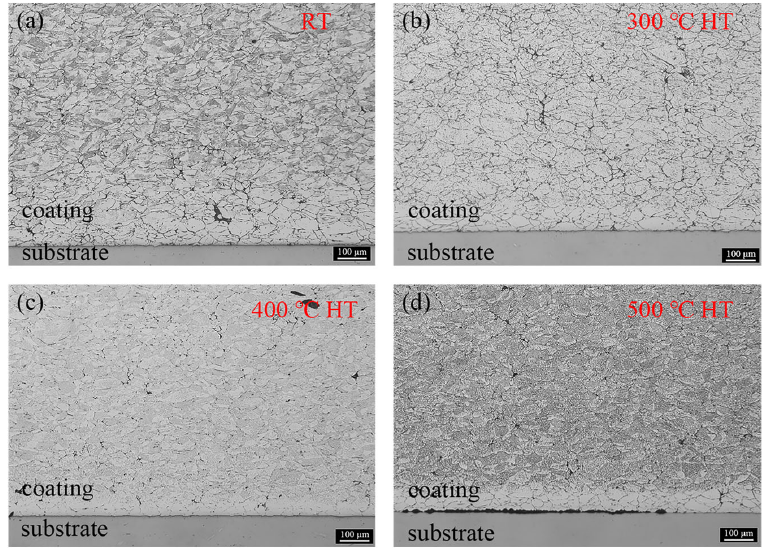
Figure 7. As-etched microstructure of Al coatings: ( a ) RT, ( b ) 300 °C HT, ( c ) 400 °C HT, and ( d ) 500 °C HT.